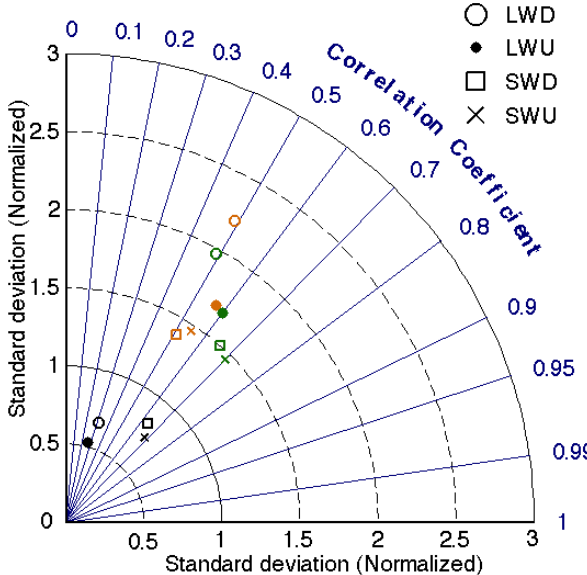
Fig. 14. Taylor diagram summarizing the normalized standard de- viation and the correlation coefficient for each of the variables in Fig.